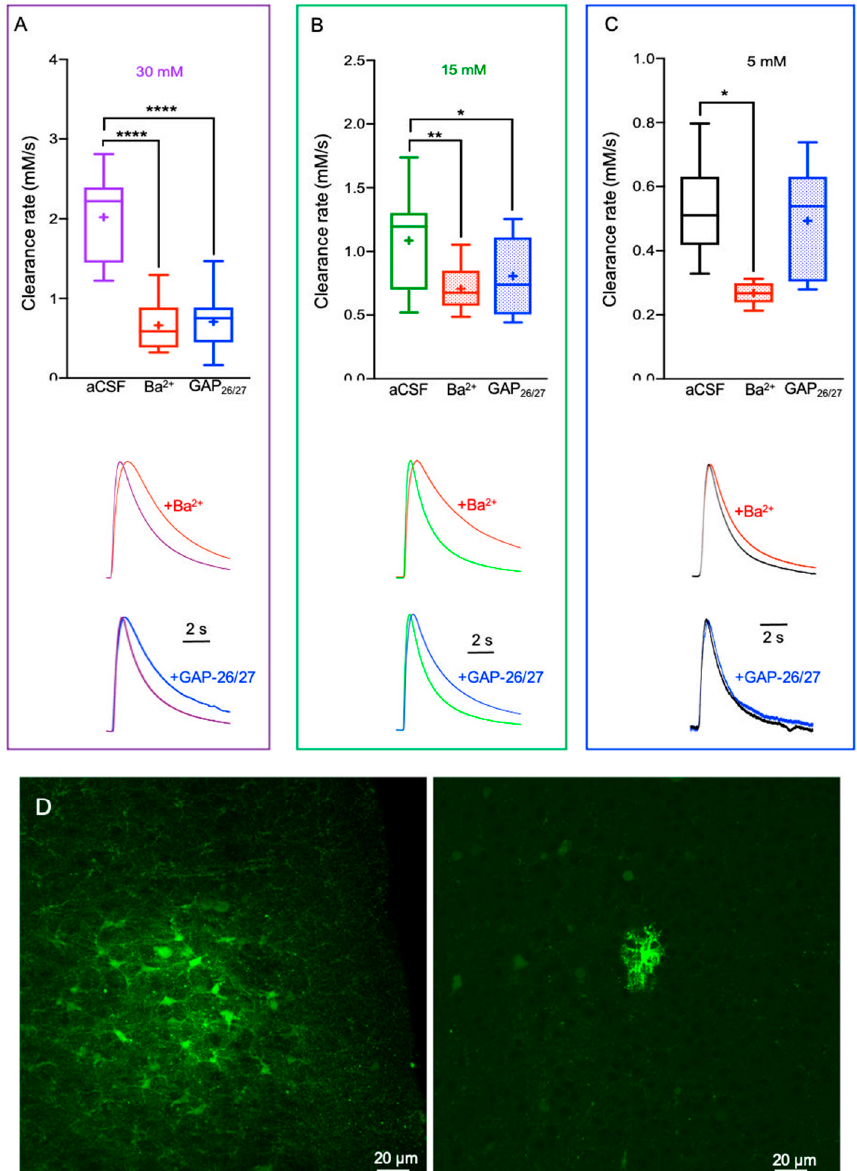
Figure 2. Impaired astrocytic K + clearance affect [K + ] o dynamics. ( A – C ) Box plots depicting the average K + clearance rate following local application of 30 mM ( A ), 15 mM ( B ), and 5 mM ( C ) KCl, under control conditions (aCSF), reduced Kir4.1 activity (red) or impaired astrocytic GJ conductance (blue). Bottom—sample traces of [K + ] o recording (normalized to the peak amplitude) under control and impaired clearance conditions; red traces- with Ba 2+ ; blue traces- with Gap-26/27 mixture. Control traces are color-coded as per their concentration (black—5 mM, green—15 mM and purple—30 mM). Box plots definition are the same as in Figure 1. * p < 0.05; ** p < 0.01; **** p < 0.0001; two-way ANOVA. ( D ) Confocal images ( × 20) of biocytin-stained astrocytes in the somatosensory cortex depicting the astrocytic network under normal aCSF conditions (left) and following application of GAP 26/27 mixture (right).